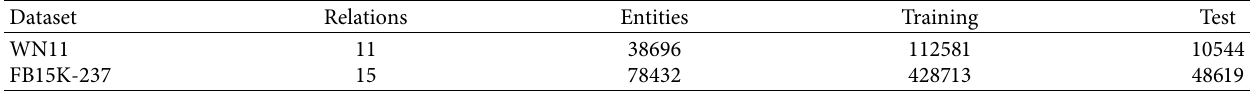
Table 1: Experimental